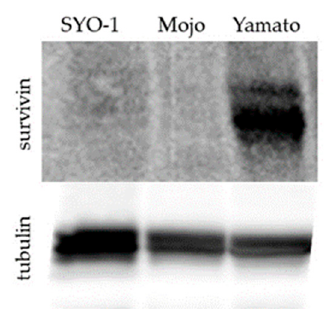
Figure A1. Immunoblot images of survivin and tubulin in human synovial sarcoma cell lines. J. Clin. Med. 2019 , 8 , x FOR PEER REVIEW